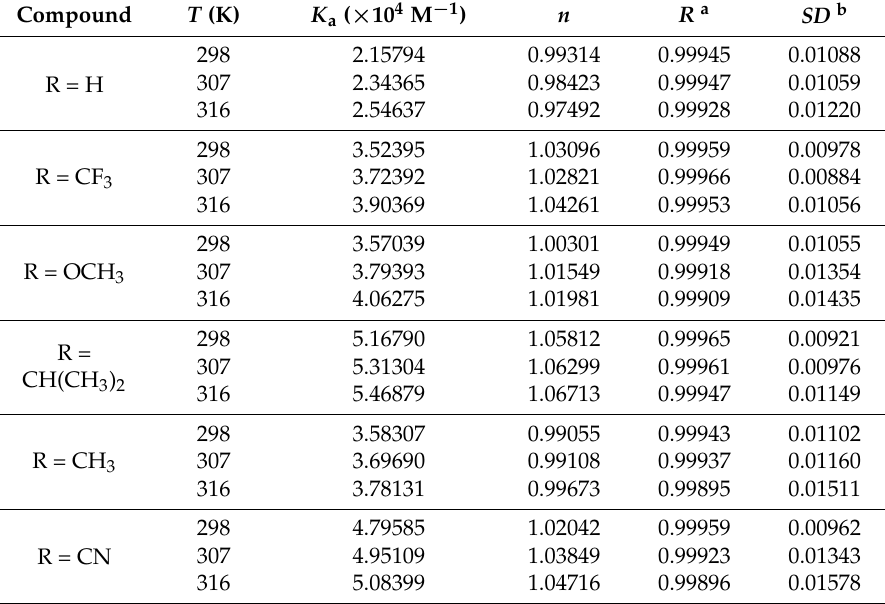
Table 2. Binding constants of PDQL to HSA.